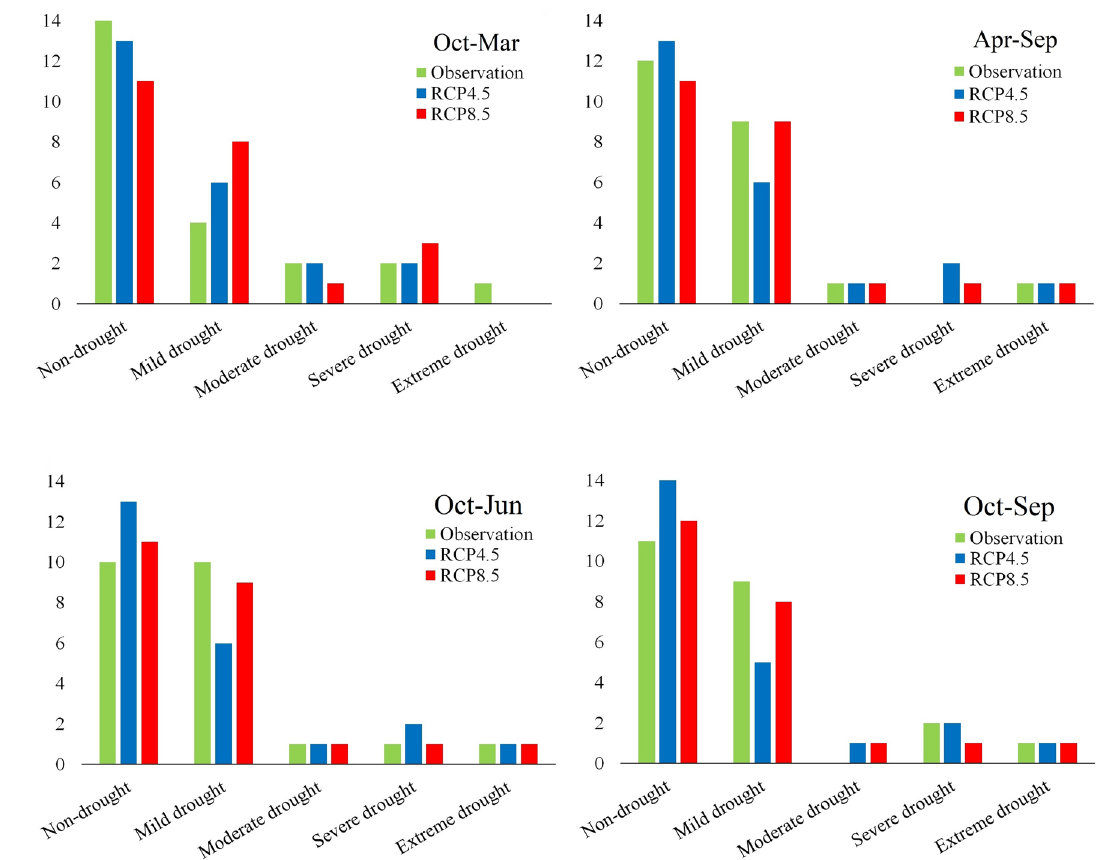
Fig. 21 a and b 6-Month c 9-Month d 12-Month Streamflow Drought Index (SDI) in the baseline and future periods under the scenarios (RCP4.5 and